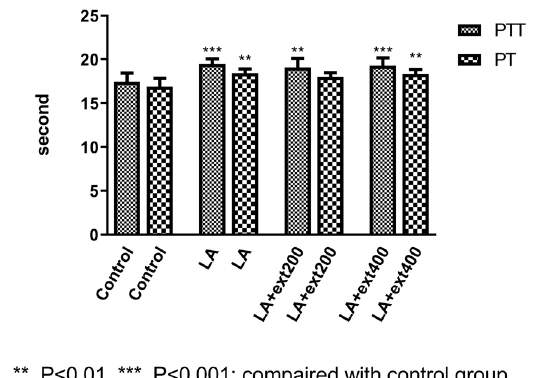
FIGURE 4 - Effect of Rheum ribes extract (ext) on prothrombin time and partial thromboplastin time in rats treated with lead acetate